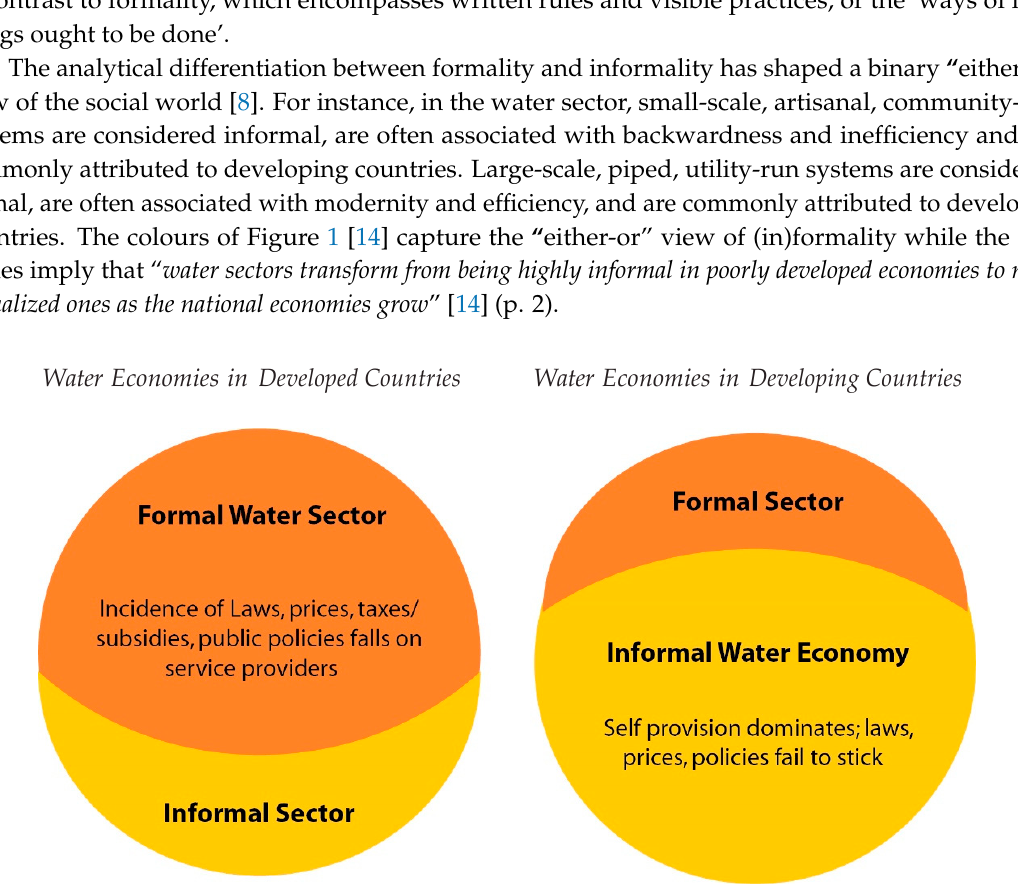
Figure 1. An “either-or” view of (in)formality and development, reproduced from [14].